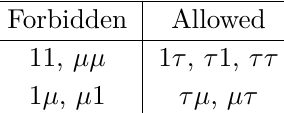
Table 5 . The forbidden and allowed configurations in the Jones-Kauffman sequences.